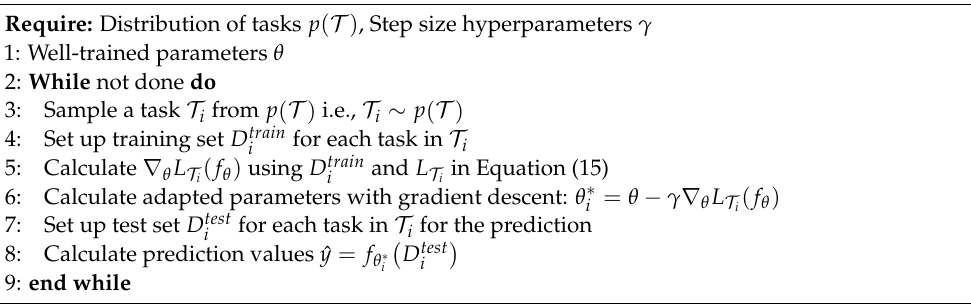
Algorithm 2 CNN-LSTM-ML Fine-tune